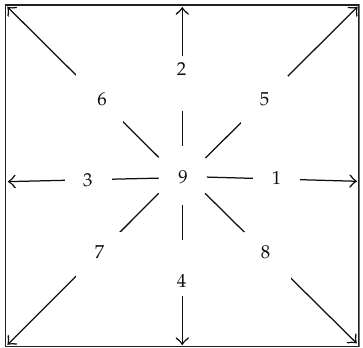
Figure 2: Topology of the D2Q9 lattice and labelling of the